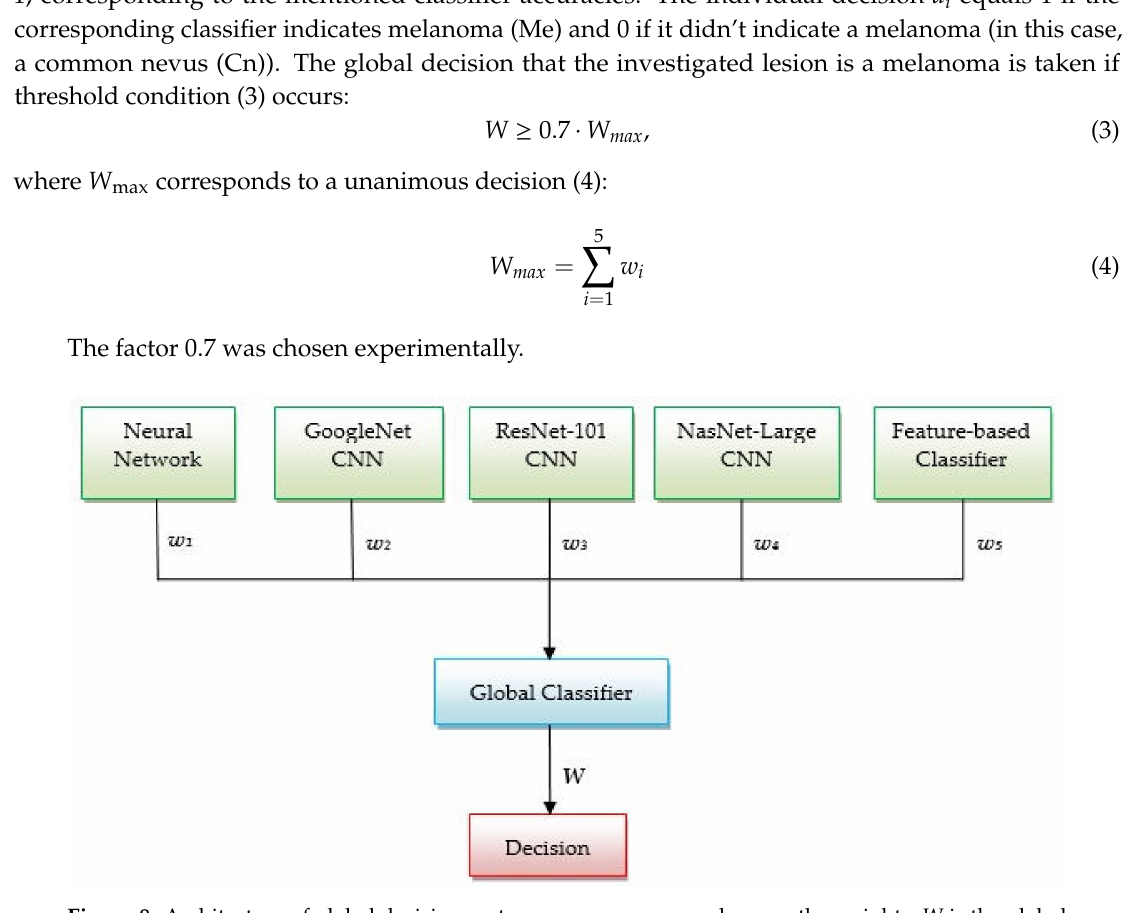
Figure 8. Architecture of global decision system w 1 , w 2 , w 3 , w 4 , and w 5 are the weights ; W is the global index of